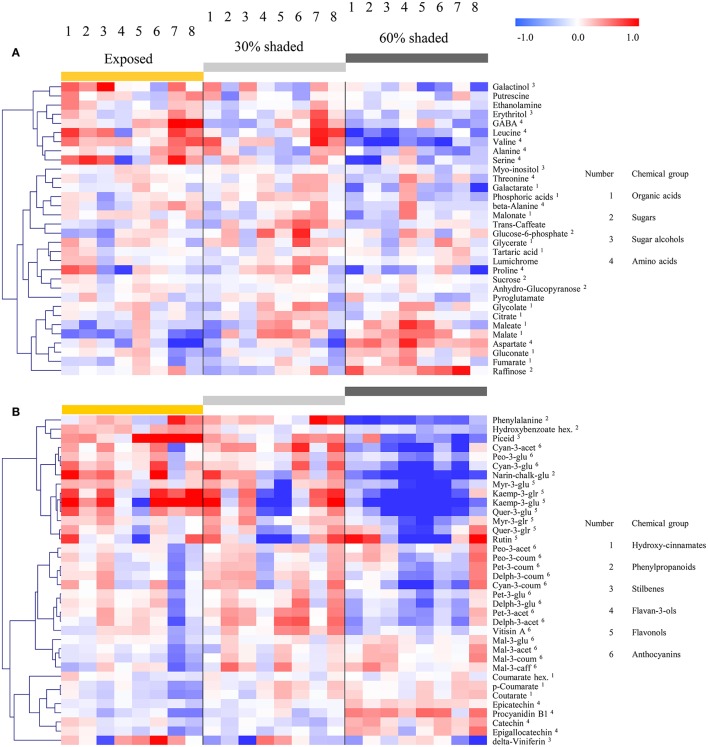
Heatmap of grape pulp primary metabolites (A) and skin phenylpropanoids (B) across eight orientations (see Figure 1) of clusters subjected to three sun exposure treatments: fully exposed clusters (exposed), clusters shaded with 30% shading nets (30% shaded) and clusters shaded with 60% shading nets (60% shaded). The heatmap was generated using the mean values of four biological replicates following normalization to the median of each metabolite based on all samples, and log2 transformation. The Pearson correlation was used for hierarchical clustering of the metabolites.